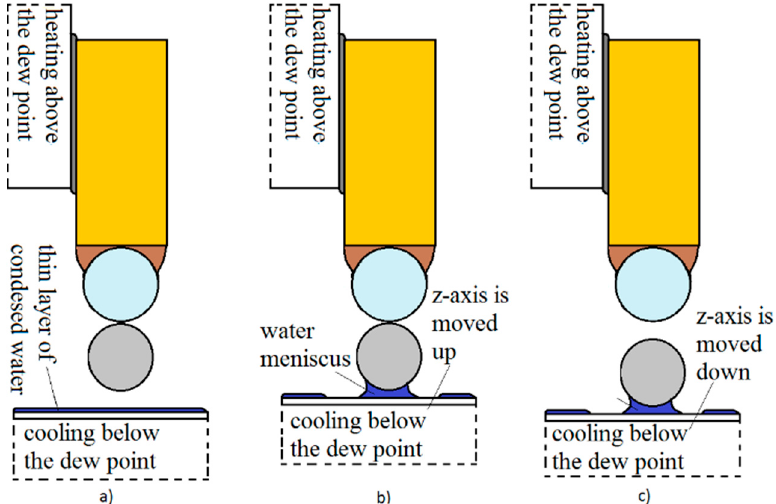
Figure 3. Releasing procedure using the capillary force method based on a thin layer of condensed water: ( a ) the water from meniscus evaporated; ( b ) a water meniscus between the object and the glass plane was created; ( c ) the object was released from the tip.